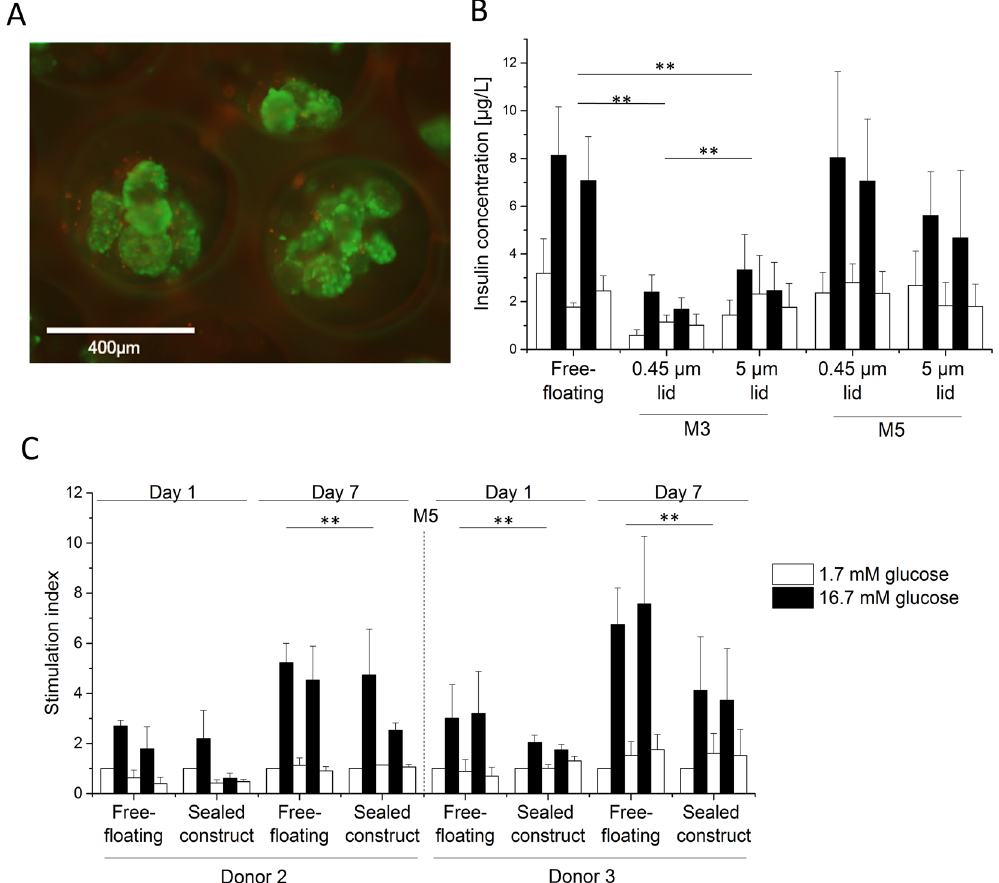
Figure 5. Human islets encapsulation. ( A ) Islets viability after 1 day of culture in closed system with M3 microwell membrane, green-live cells, red-dead cells, ( B ) Islets functionality using a closed system with various porosities of the lid and various thickness of microwell membranes: 250 µ m thick microwell membrane after 24 h treatment – M3 and 100 µ m thick microwell membrane after 24 h treatment – M5, ( C ) Functionality of islets from two donors over 7 days using a sealed device. To compare response to glucose concentration changes of islets from two donors, the insulin secretion is normalized to the first low glucose stimulation and presented as a stimulation index. Error bars indicate standard deviation (n = 3), ** p <